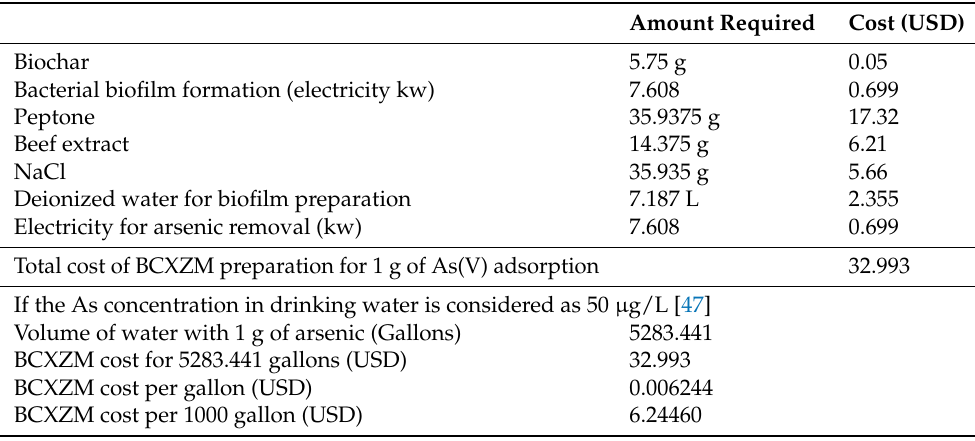
Table 3. Cost of BCXZM preparation for the adsorption of 1 g As(V), based on the adsorption capacity of 42.3